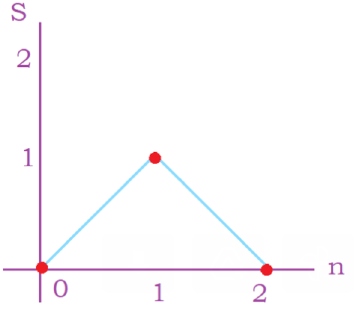
Figure 18 . The entropy S at T = 0